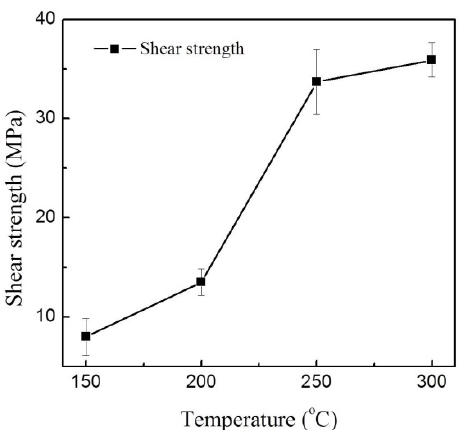
Figure 4. The shear strength of the Ag nano paste joint on different temperatures after sintering for 2 h.